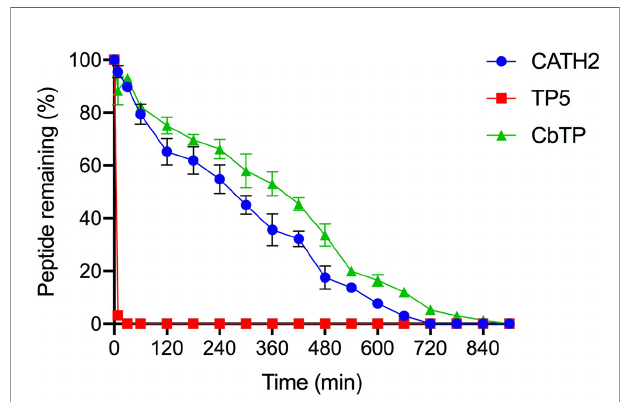
FIGURE 5 | The mean human serum concentrations of CATH2, TP5, and CbTP over time. The concentration of each target peptide in serum in vitro at the selected time points was quanti fi ed by HPLC. The data are given as the mean ± standard deviation (n=5).